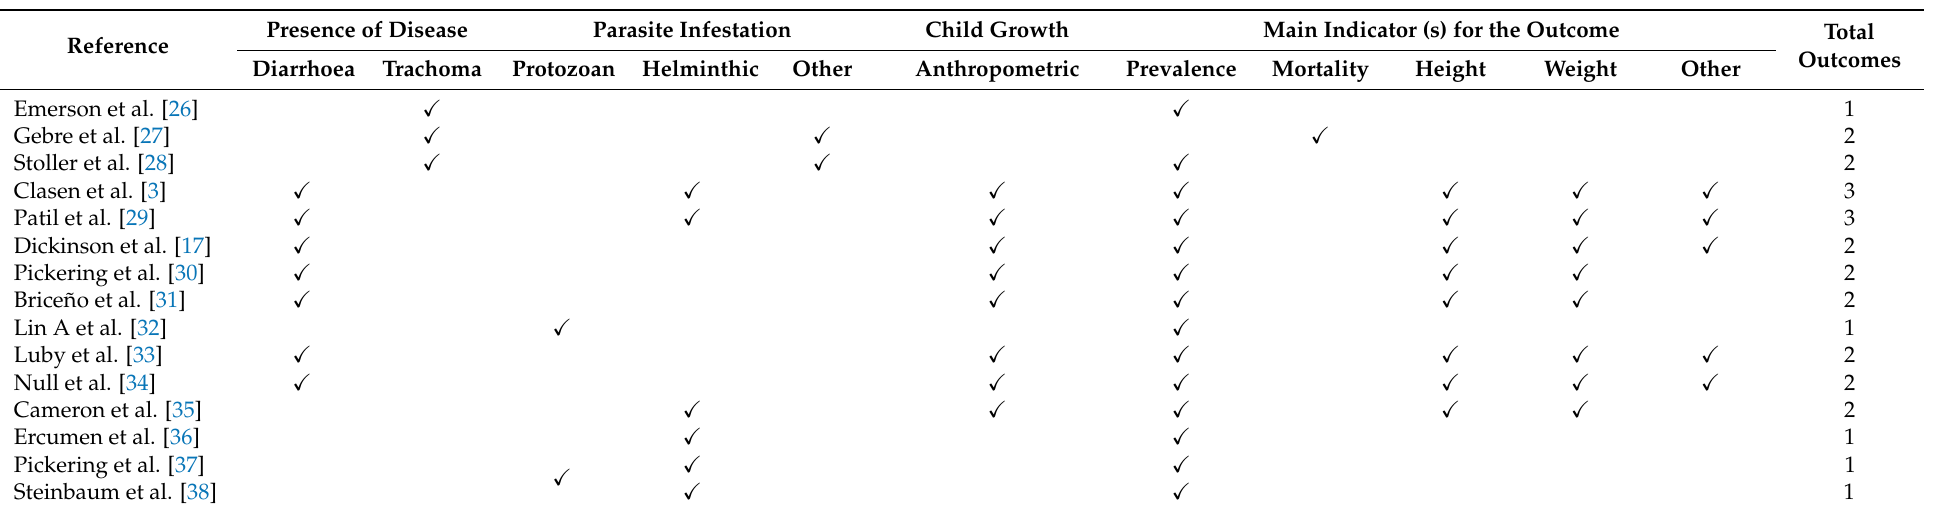
Table 3. Main health outcomes upon which the effect of sanitation was assessed in the intervention as indicated in the included studies.